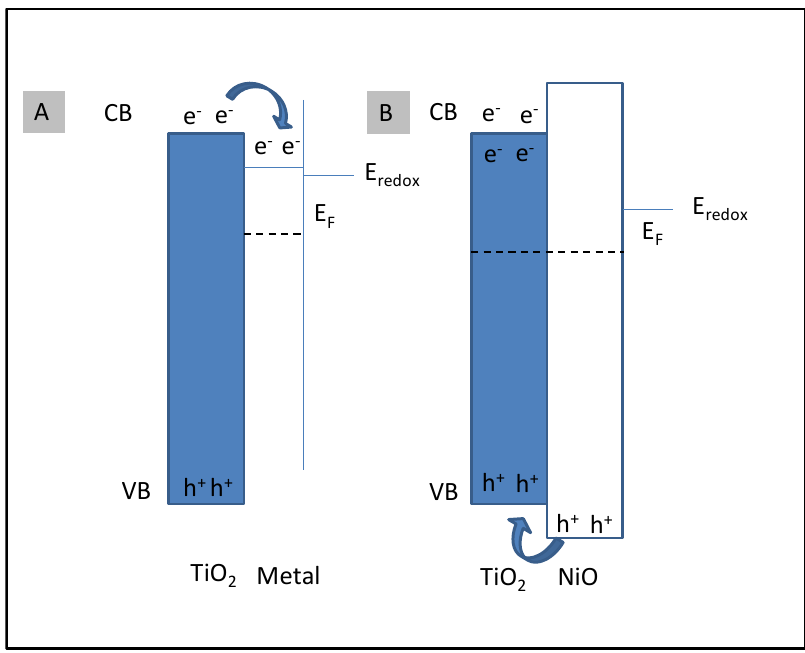
Figure 9. Energy levels of ( A ) TiO 2 / metal and ( B ) TiO 2 / NiO, adapted from Bahruji et al [30].